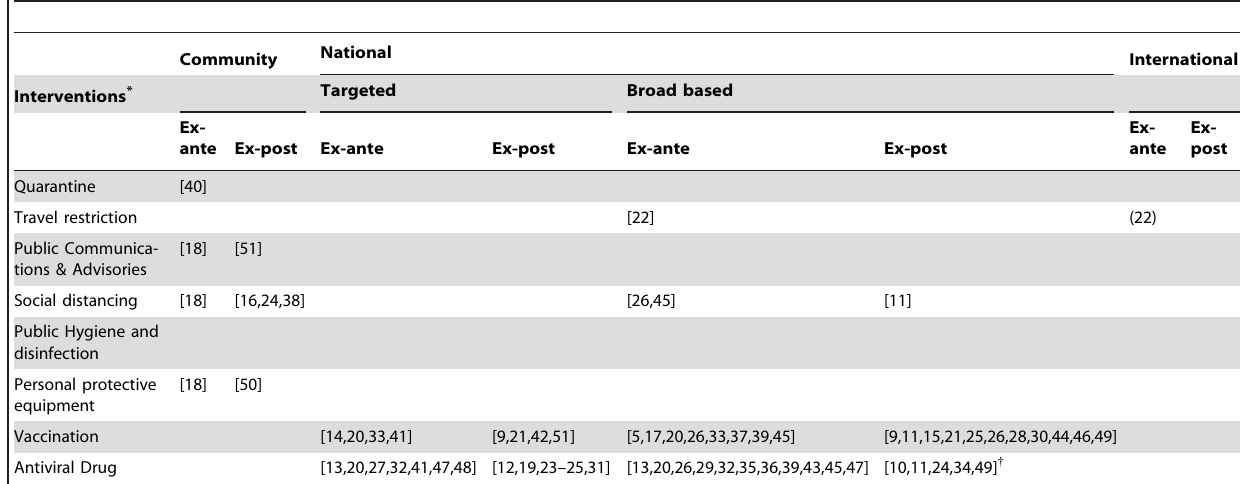
Table 2. Classification of studies by types of interventions, modified from the WHO and World Bank’s taxonomy [52,53].